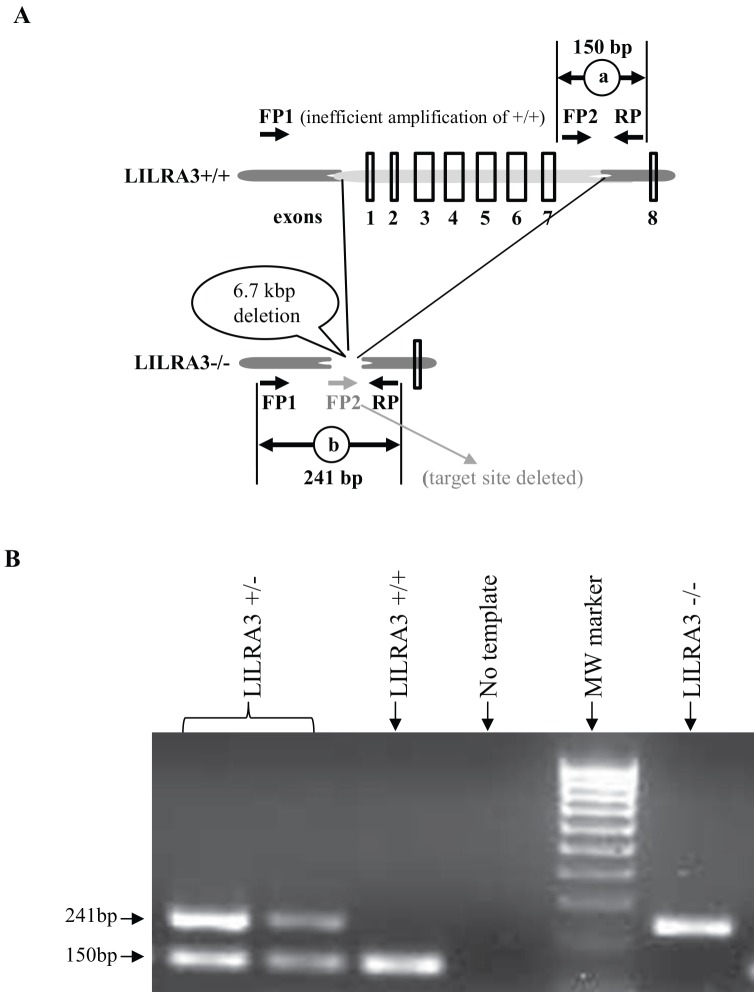
LILRA3 genotyping schematic diagram and representative results.(A) Schematic illustration of LILRA3 genotyping strategy used to distinguish LILRA3 gene deletion polymorphisms (adapted from [24]). Two forward (FP1 and FP2), and one reverse (RP) primers were used in a single PCR reaction. In subjects with two intact LILRA3 alleles, FP1 primer which is upstream from the 6.7kbp deletion together with the RP will poorly amplify the very large size product spanning the entire 8 LILRA3 exons; instead a single 150bp product will be efficiently amplified by the downstream FP2 primer. Subjects who are heterozygous will show a 241bp product from the deleted allele and a 150bp product from the intact allele, and subjects with homozygous gene deletion will preferentially amplify the 241bp product. (B) A representative 2% agarose gel for LILRA3 PCR products showing two patients with MS having heterozygous gene deletion (LILRA3+/-; lane 1, 2), one patient showing two intact LILRA3 alleles “wild type” (LILRA3+/+; lane 3) and one patient showing a homozygous deletion “null allele” (LILRA3 -/-; lane 6). Lane 4 is a no template control and lane 5 is the molecular weight marker.